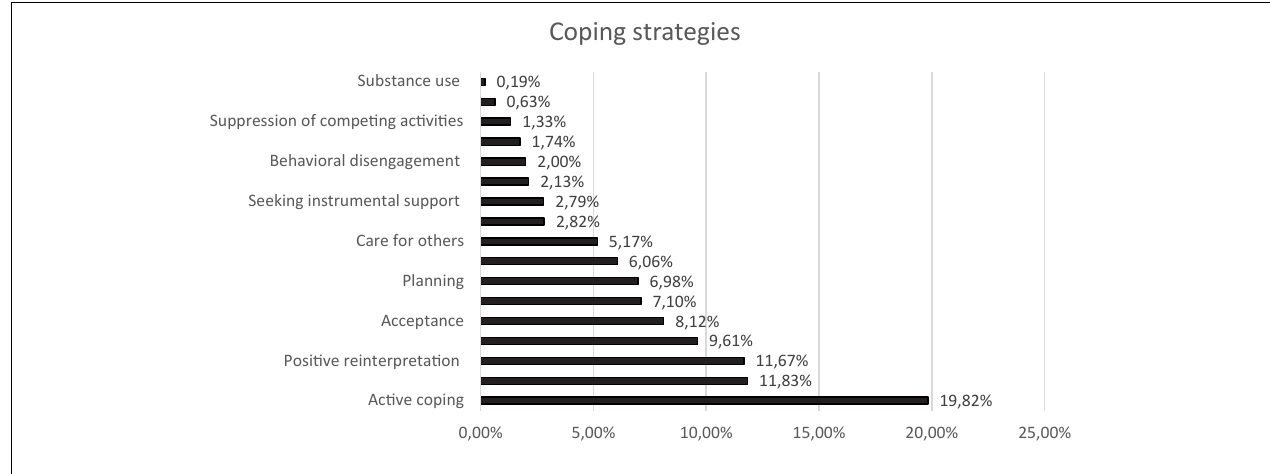
FIGURE 1 | Frequency of the various coping strategies based on the COPE.